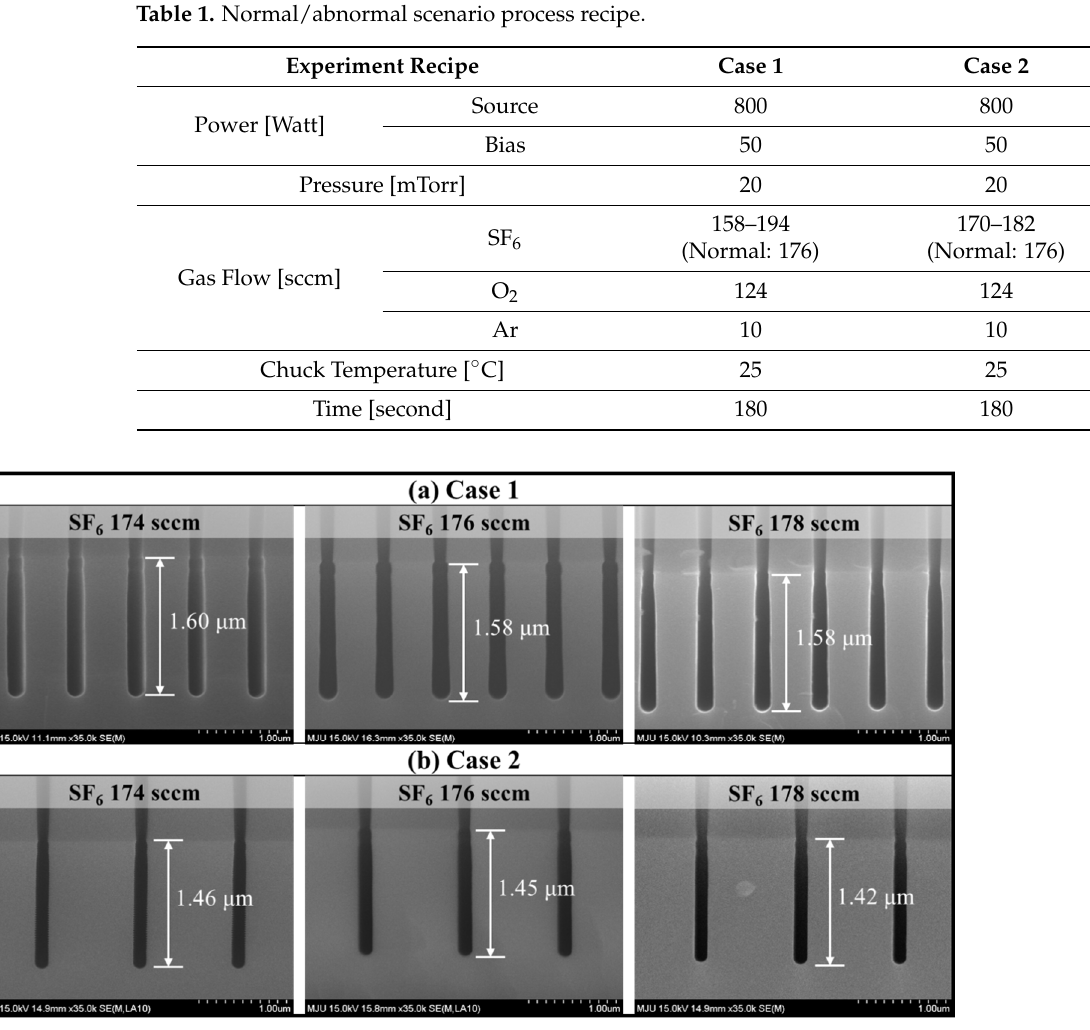
Figure 2. Cross-sectional SEM image about the process results.